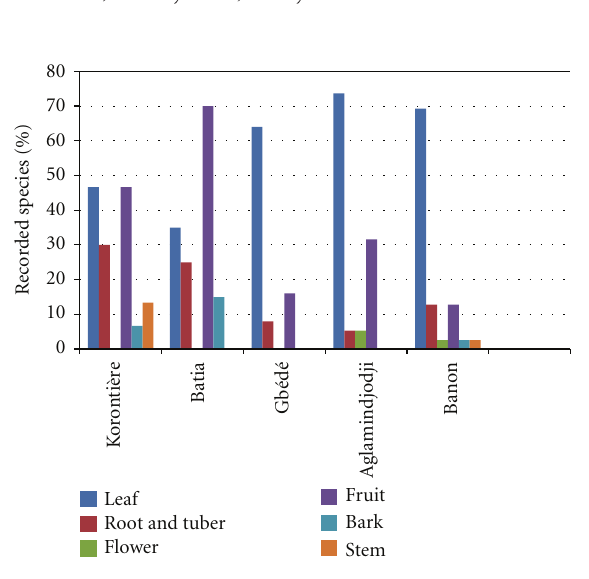
Figure 3: Relative importance of the species under domestication with regard to their organs used across villages.